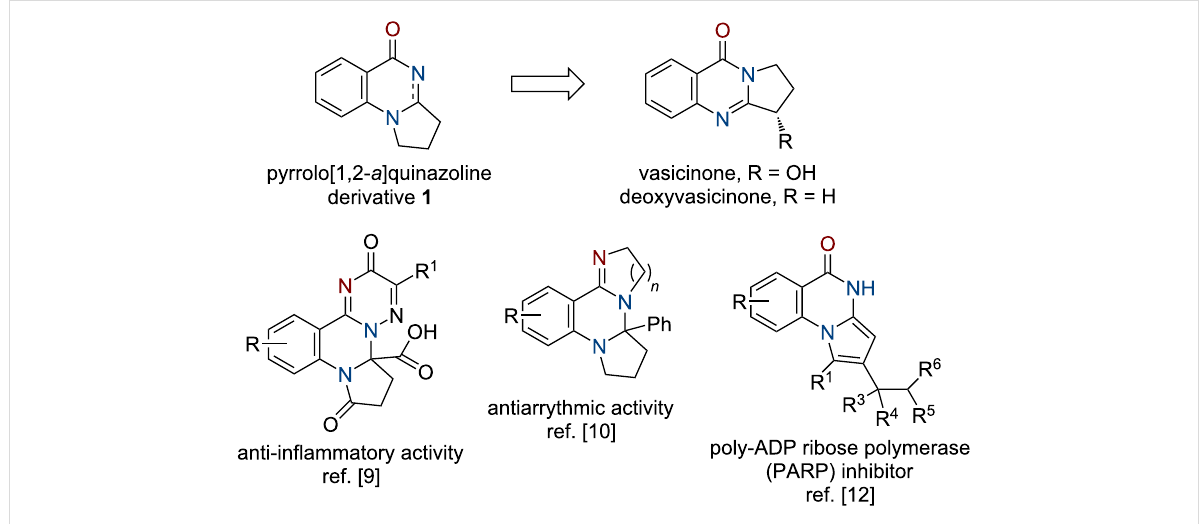
Figure 1: Pyrrolo[1,2- a ]quinazoline derivatives – analogs of vasicinone alkaloids and their biological activity.